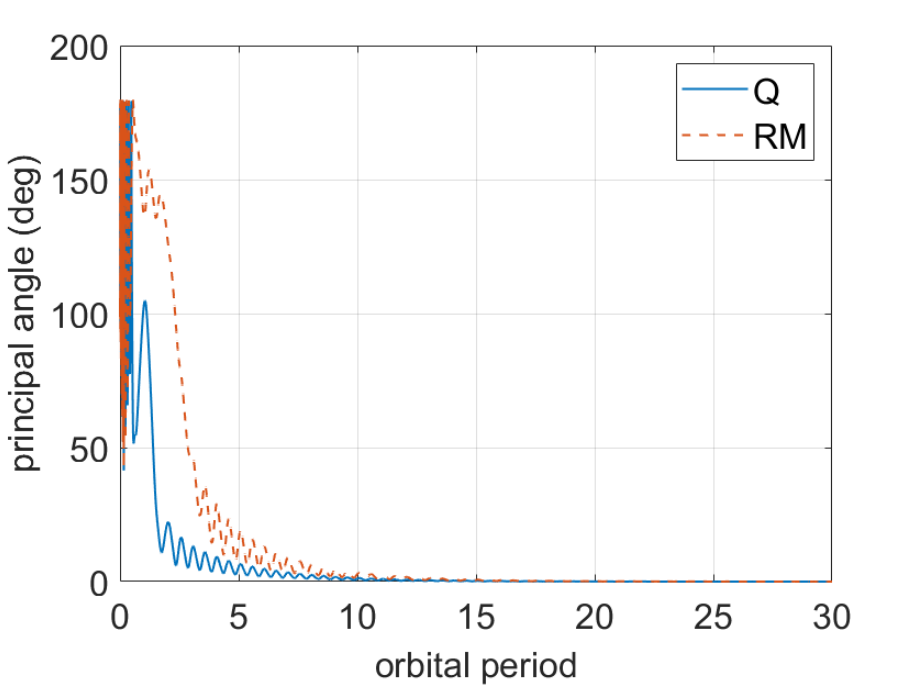
Figure 1. Time histories of principal angle using quaternion feedback (Q, blue solid line) and using rotation matrix feedback (RM, red dashed line) (single run of the Monte Carlo campaign for the nominal